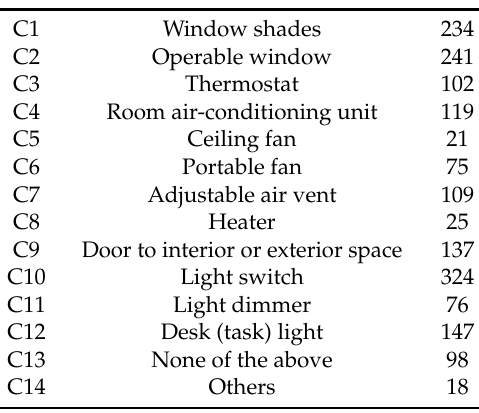
Table 2. Frequencies of control opportunities.